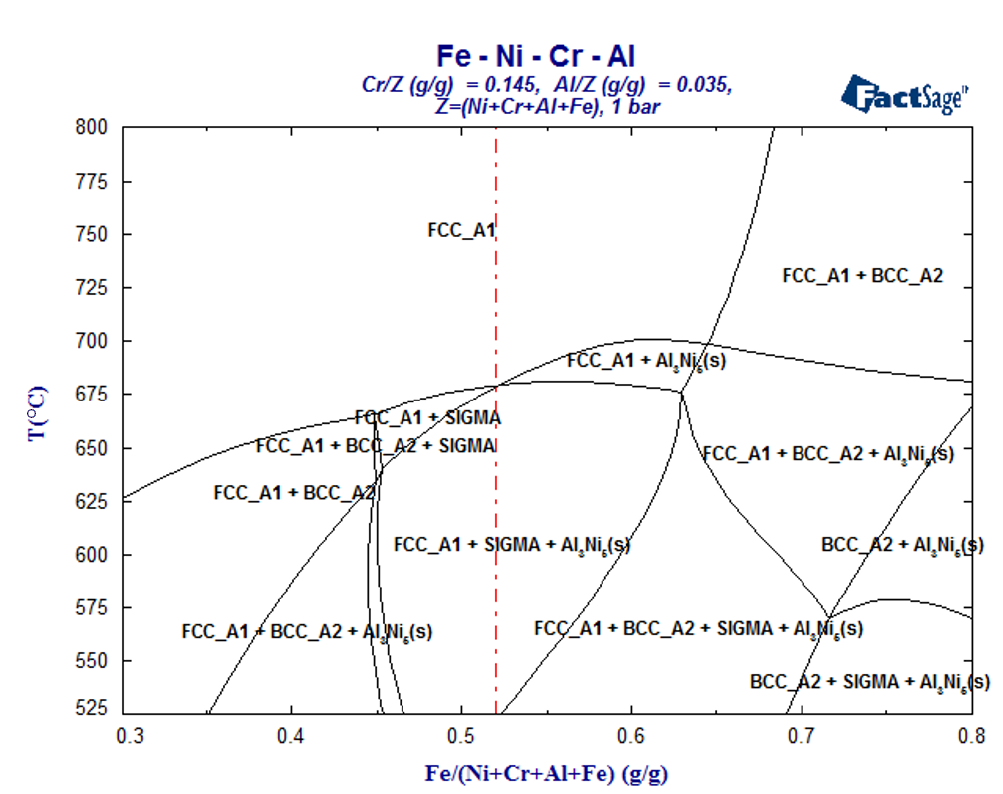
Figure 1. Phase diagram of the designed FeNiCrAl alloy. Selected material composition is marked with a dotted line. FCC_A1 = austenitic and FCC_A2 =